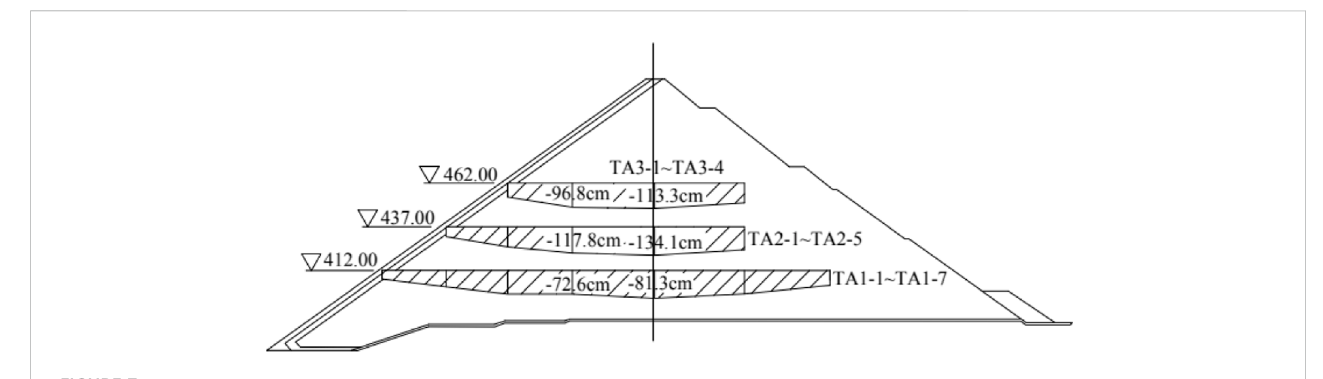
FIGURE 7 Vertical deformation of dam In March